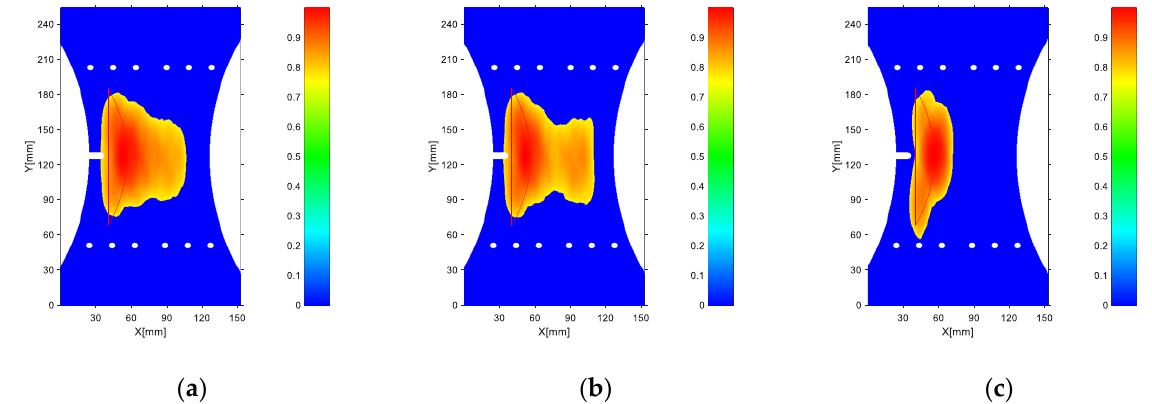
Figure 15. Thresholded imags for different damage factors at 20,000 fatigue cycles: ( a ) energy damage factor; ( b ) cross-correlation damage factor; ( c ) sparse representation damage factor.